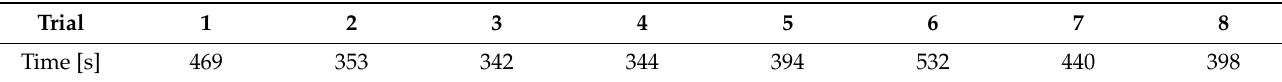
Table 1. Selected trials.